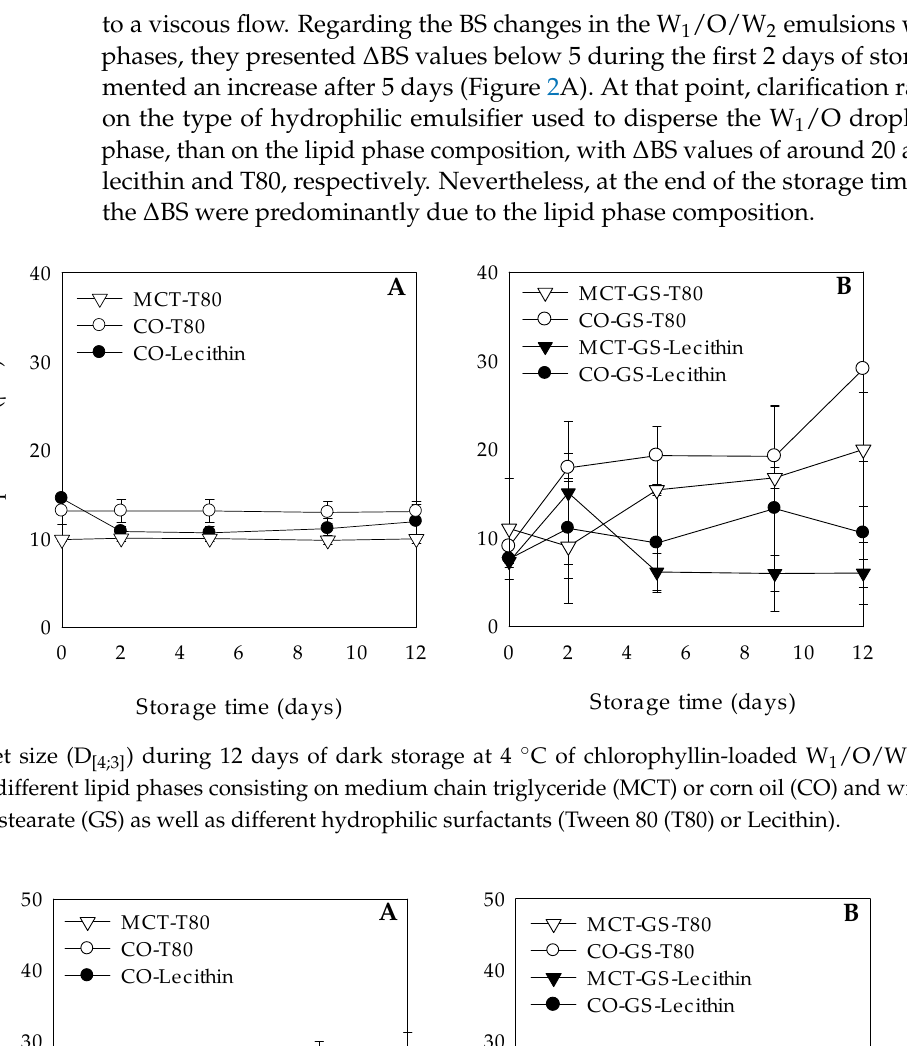
Figure 1. Droplet size (D [4;3] ) during 12 days of dark storage at 4 °C of chlorophyllin-loaded W 1 /O/W 2 emulsions formulated with different lipid phases consisting on medium chain triglyceride (MCT) or corn oil (CO) and without ( A ) or with ( B ) glyceryl stearate (GS) as well as different hydrophilic surfactants (Tween 80 (T80) or Lecithin).